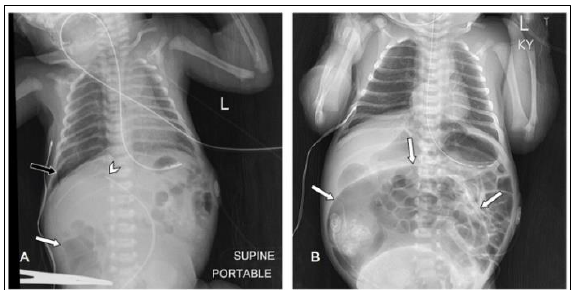
Figure 2: Chest and abdomen radiographs approximately 14 hours apart demonstrating rapid progression of bowel dilation. A) Day of life 0 radiograph shows a nonobstructive bowel gas pattern with mild distention of the right colon (white arrow). Note the malpositioned umbilical venous catheter-directed towards the right portal vein (arrowhead) and small right pneumothorax (black arrow). B) Day of life 1 radiograph shows massive gaseous dilation of the congenital sigmoid pouch colon (arrows).